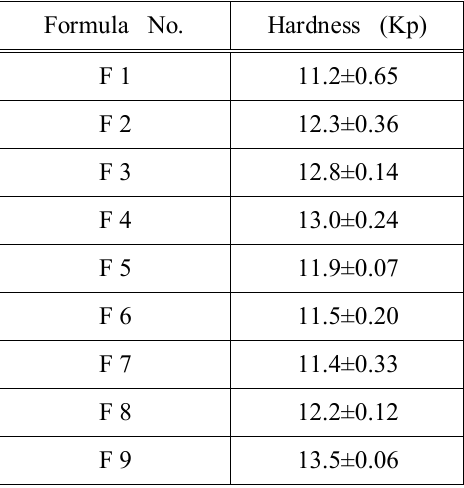
Table 2: Hardness of Tablets (expressed as mean ± SD).